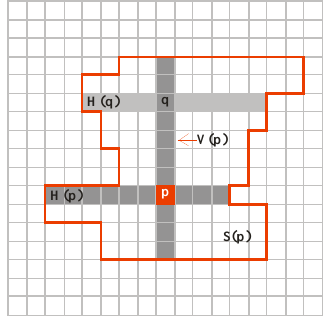
Figure 5. Threshold τ (l q ) imposed on colour difference between pixels p and q is linearly reduced (red curve) as q approaches the limit of maximum window size. The green lines depict the form of the two thresholds originally proposed in literature for handling extended texture-less image areas.